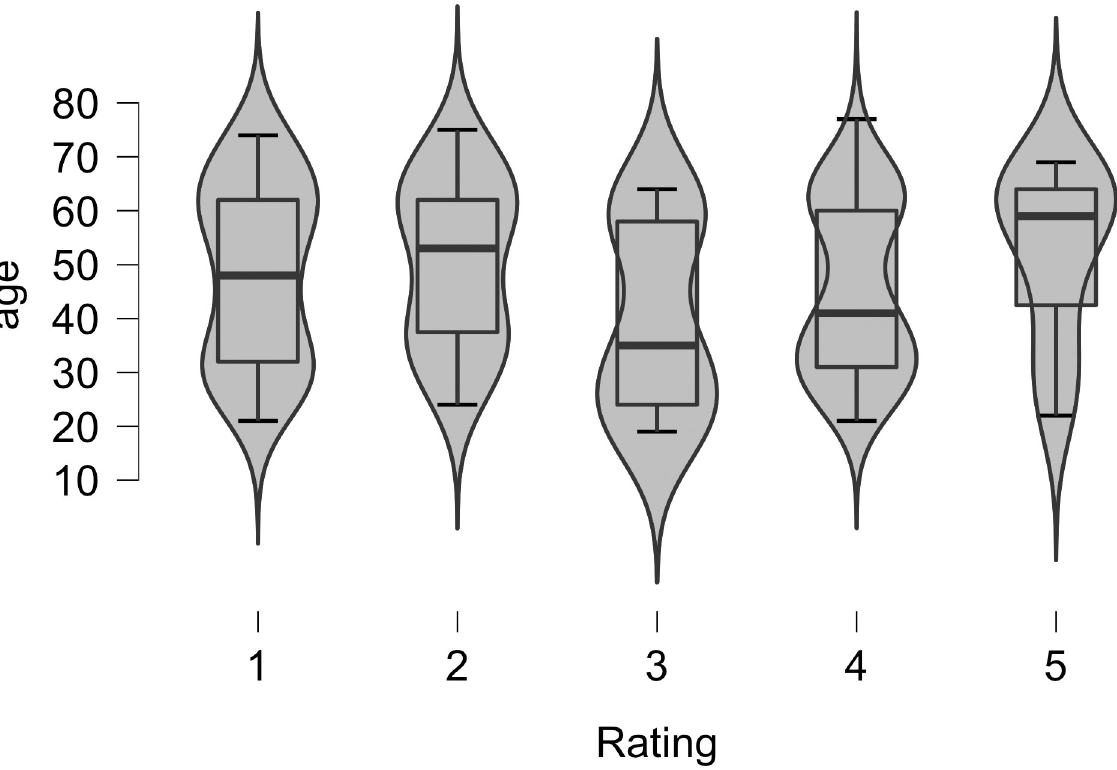
Fig 3. Violin plots with box plots superimposed of the ages for each song rating (1 = sounds like speech, 5 = sounds like song) for 126 participants. The violin plot shows the distribution of ages for each rating. The box plot shows the median age (the dark horizontal lines), the 75 th to the 25 th quartiles (the boxes), and the upper and lower boundaries of 1.5 � 75 th (or 25 th ) quartiles (the whiskers).